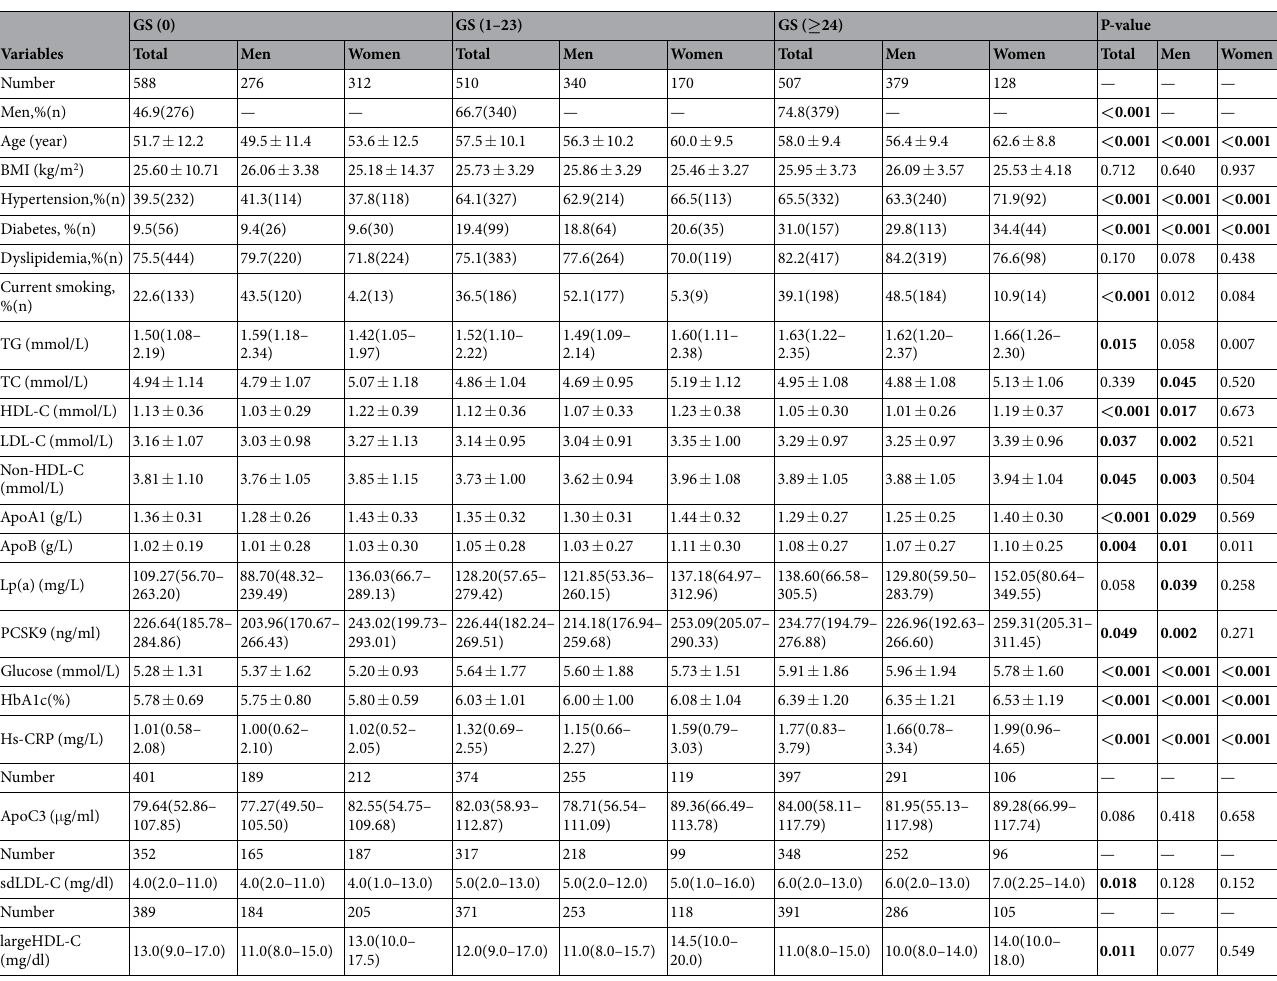
Table 1. Baseline characteristics of patients according to coronary severity. Data shown were mean ± SD, media (Q1-Q3) or %(n). The bold values indicated statistical significance and were bolded to improve the readability of the table. Abbreviations: GS, Gensini score; BMI, body mass index; TG, triglyceride; TC, total